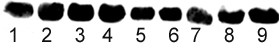
Western blot analysis of pBad immunoprecipitated with 14-3-3 in MEF cells: WT, Bid -/- and DKO: WT lanes 1-3; 1-control, lanes (2-3) in the presence of xanthurenic acid: lane 2-10 μM, lane 3- 20 μM; Bid -/-: lane 4-control, lanes (5-6) in the presence of xanthurenic acid: lane 5-10 μM, lane 6- 20 μM; DKO lanes 7-9; lane 7-control, lanes (8-9) in the presence of xanthurenic acid: lane 8-10 μM, lane 9- 20 μM.